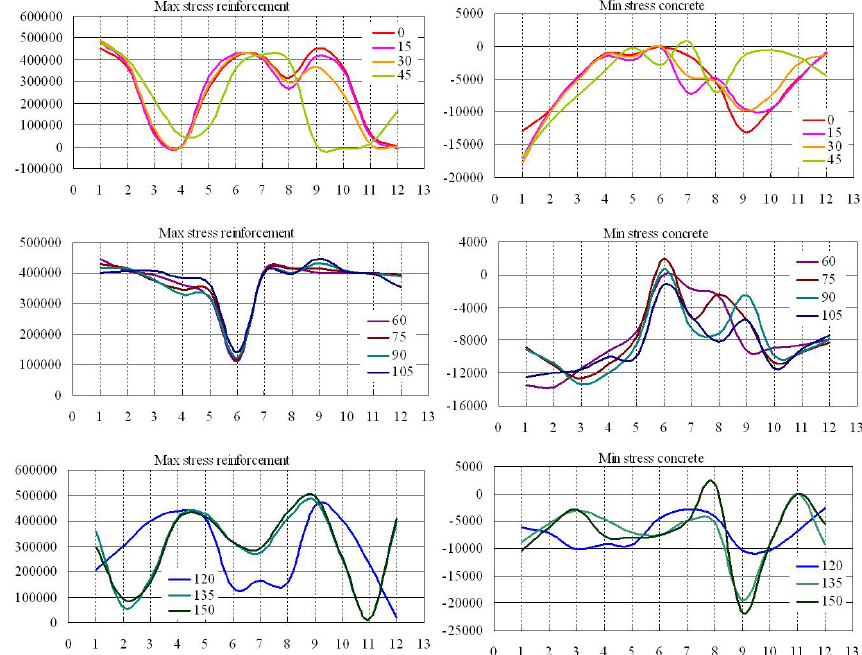
Fig. 5. Building stresses (in kPa) computed in the frame sections, for inclination angles of imposed displacements ranging from. 0 ◦ to 150 ◦ , and fixed magnitude